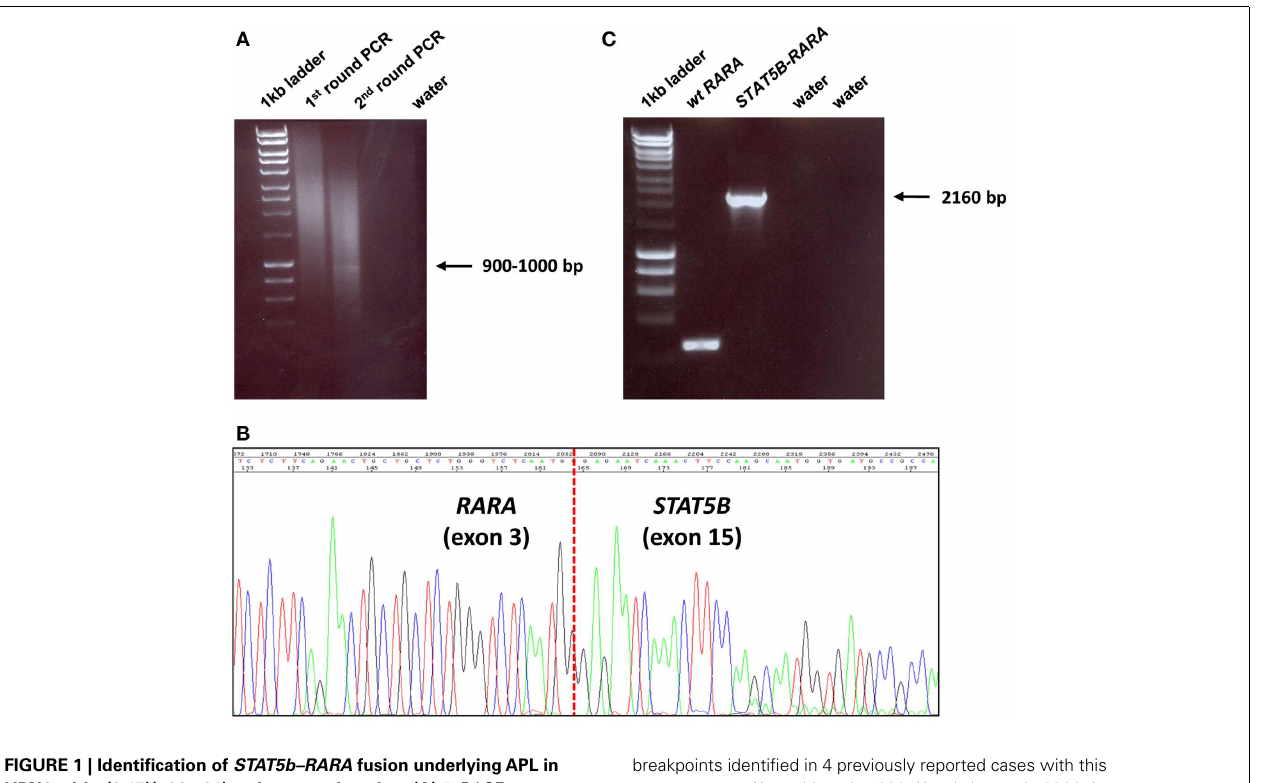
FIGURE 1 | Identification of STAT5b–RARA fusion underlyingAPL in UPN6 with t(3;17)(q26;q21) variant translocation. (A) 5 (cid:2) RACE was undertaken, which showed a weak band on second round PCR; the amplification product was cloned, sequenced and found to be a fusion between STAT5b exon 15 and RARA exon 3 (B) , in accordance with the